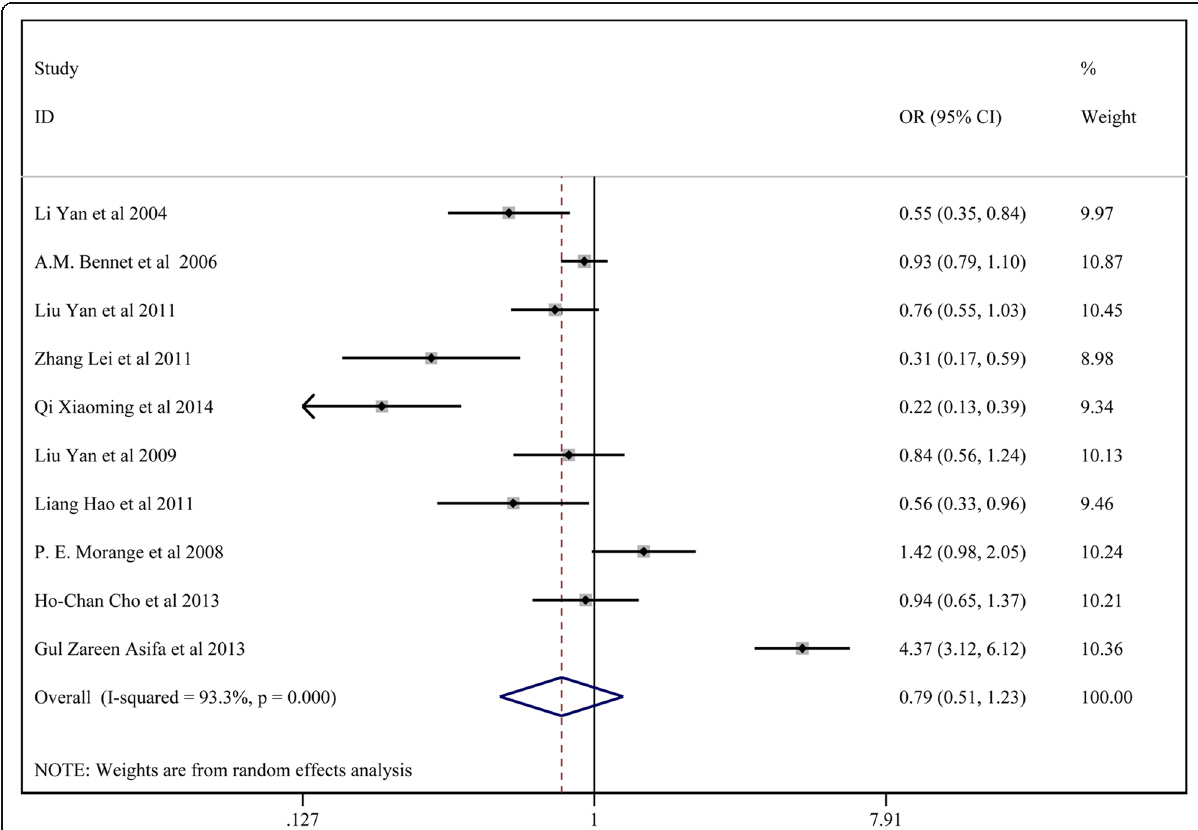
Fig. 7 Forest plot for the dominant model of TNF- α 863C/A polymorphisms associated with CAD